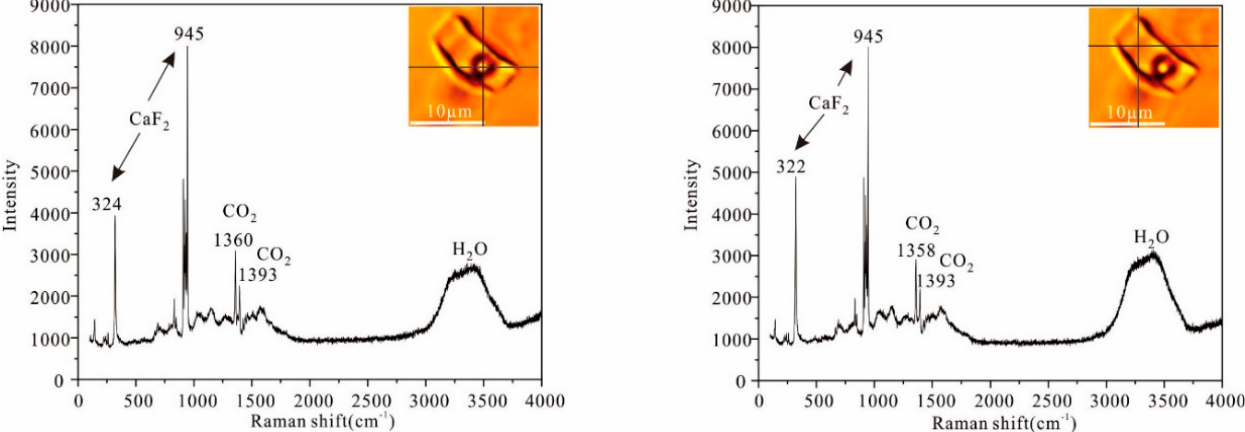
Figure 10. Laser Raman spectra of fluid inclusions in the fluorite from the Shuanghuajiang fluorite deposit.